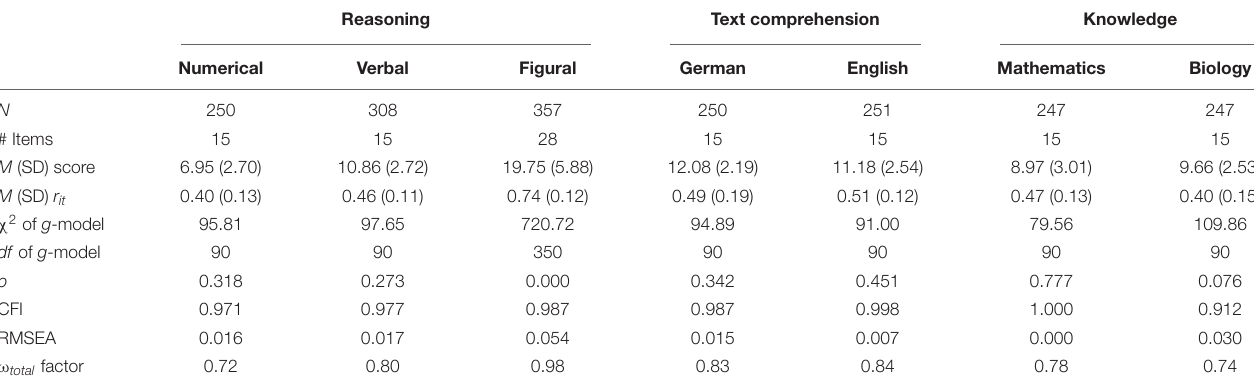
TABLE 3 | Descriptive statistics and fit indices of confirmatory factor analysis.